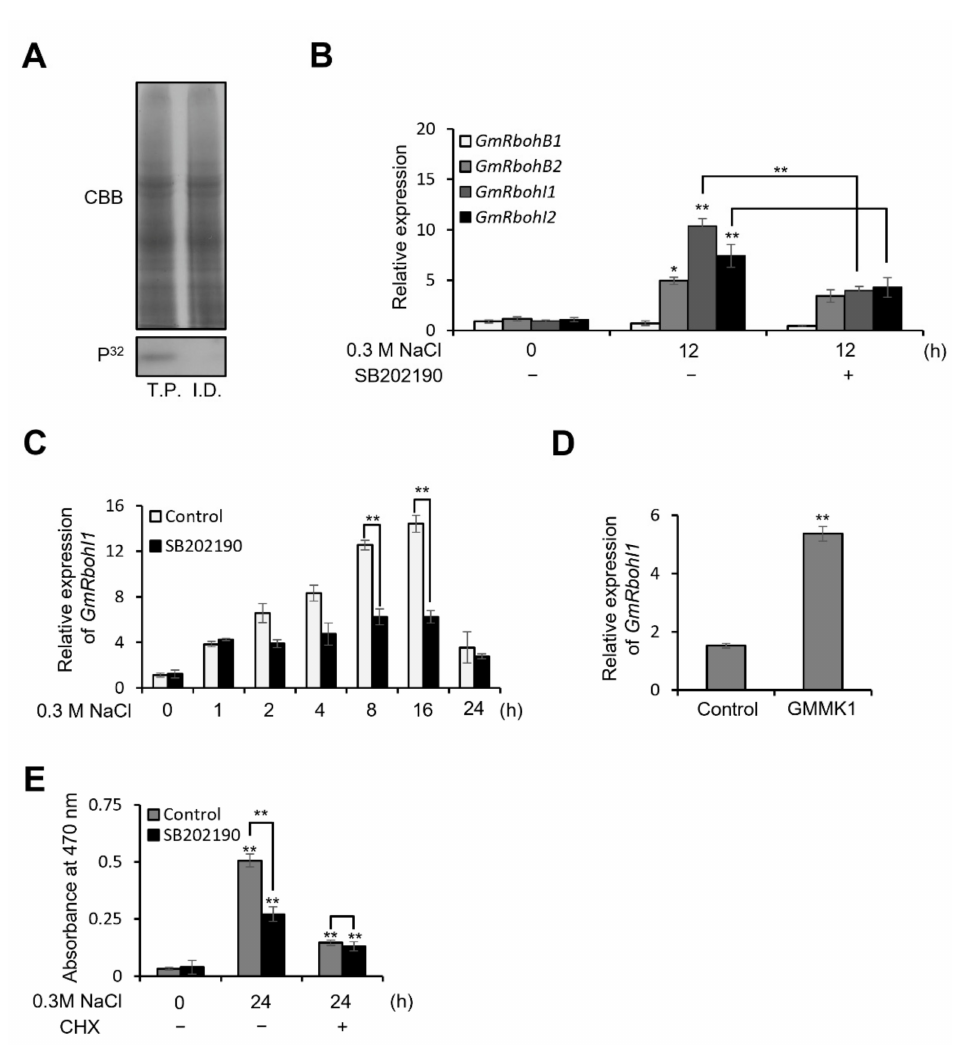
Figure 1. GmMPK6 increases expression of GmRbohI1 . ( A ) Immunodepletion and in-gel kinase assay of GmMPK6. Seven-day-old soybean seedlings were treated with 0.3 M NaCl for 5 min, and total protein was isolated from the seedlings. The protein was incubated with anti-GmMPK6 and incubated for 3 h at 4 ◦ C. Then, protein A-Sepharose was added and incubated for 3 h at 4 ◦ C. After removing the beads, total protein was separated with SDS-PAGE and an in-gel kinase assay was carried out. T.P., total protein; I.D., GmMPK6-immunodepleted total protein. ( B ) Gene expression analysis of GmRbohB1 , GmRbohB2 , GmRbohI1 , and GmRbohI2 in salt treatment with MPK6 inhibitor pretreatment. Seven-day-old soybean seedlings were treated with 0.3 M NaCl for 12 h with or without 1 h pretreatment of 30 µ M SB202190. Total RNA was isolated from the seedlings and RT-qPCR